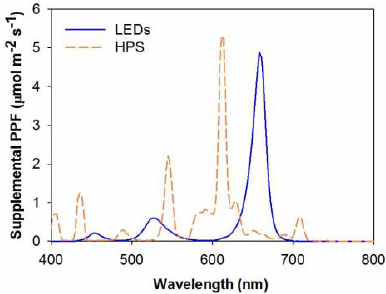
Figure 2. The wavelengths of spectra of LED and HPS lightings. PPF, photosynthetic photon flux.